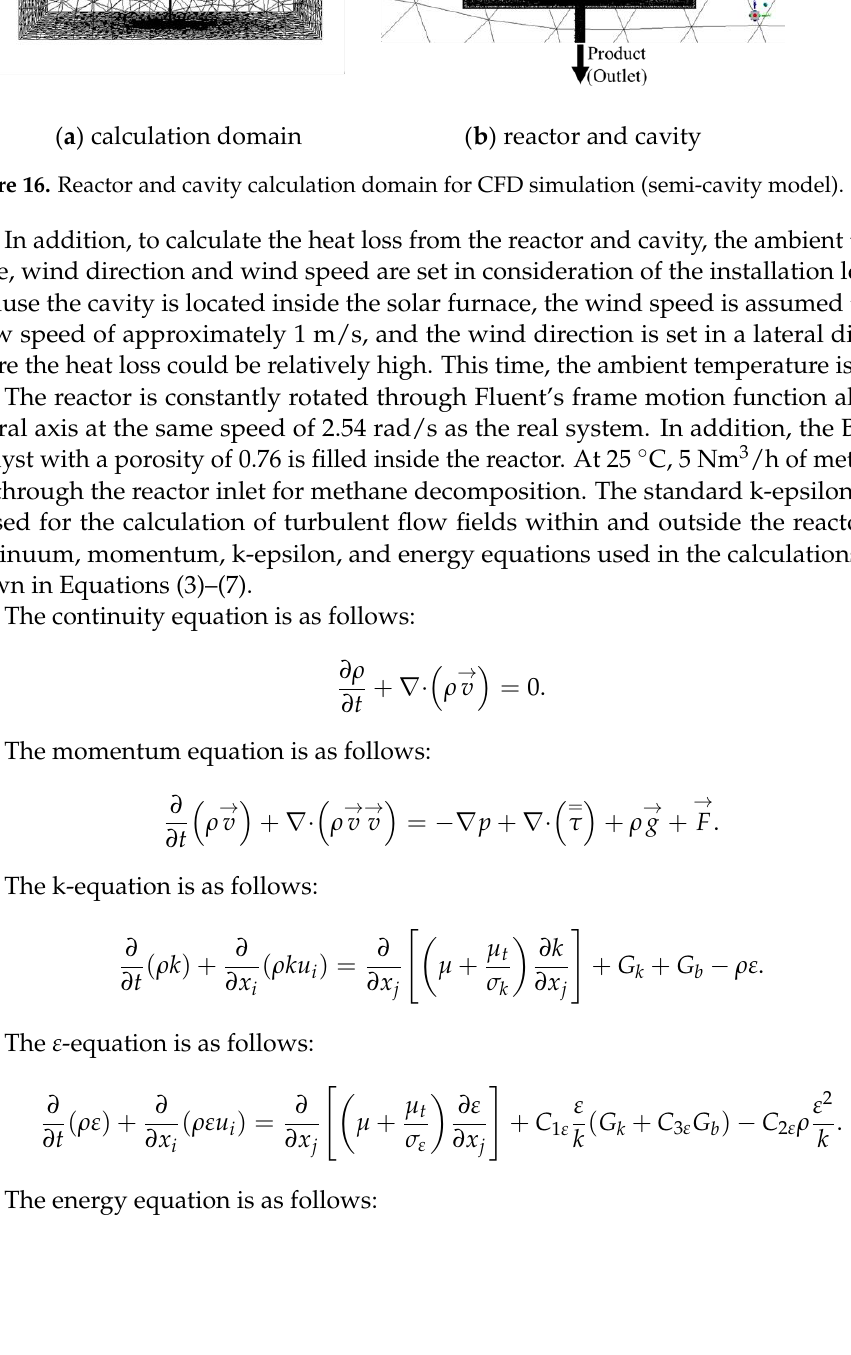
Figure 16. Reactor and cavity calculation domain for CFD simulation (semi-cavity